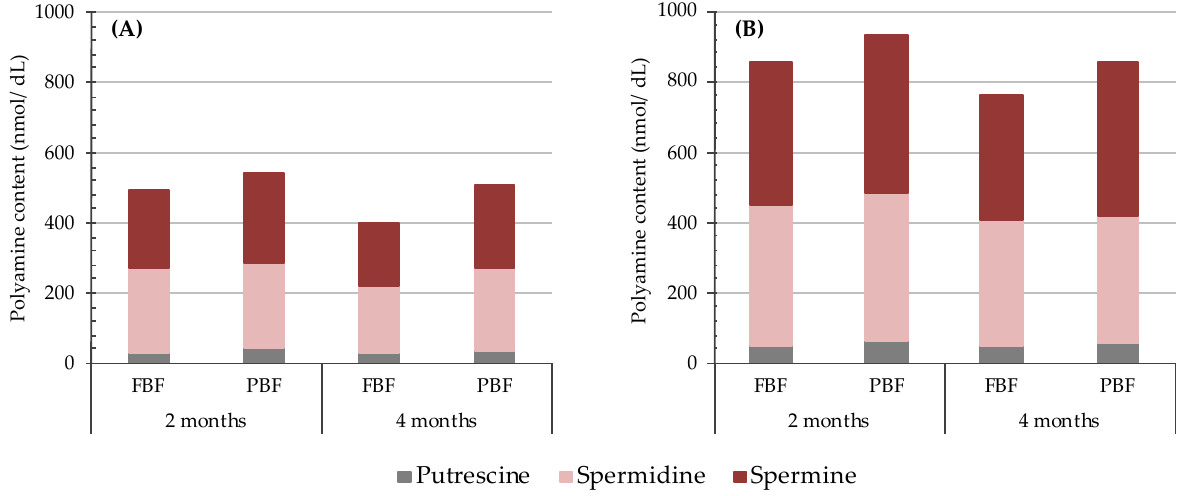
Figure 4. Polyamine levels (nmol/dL) in foremilk ( A ) and hindmilk ( B ) according to the type of breastfeeding (FBF: full breastfeeding and PBF: partial breastfeeding) at two and four months of lactation. FBF group n = 60 and PBF group n = 23.